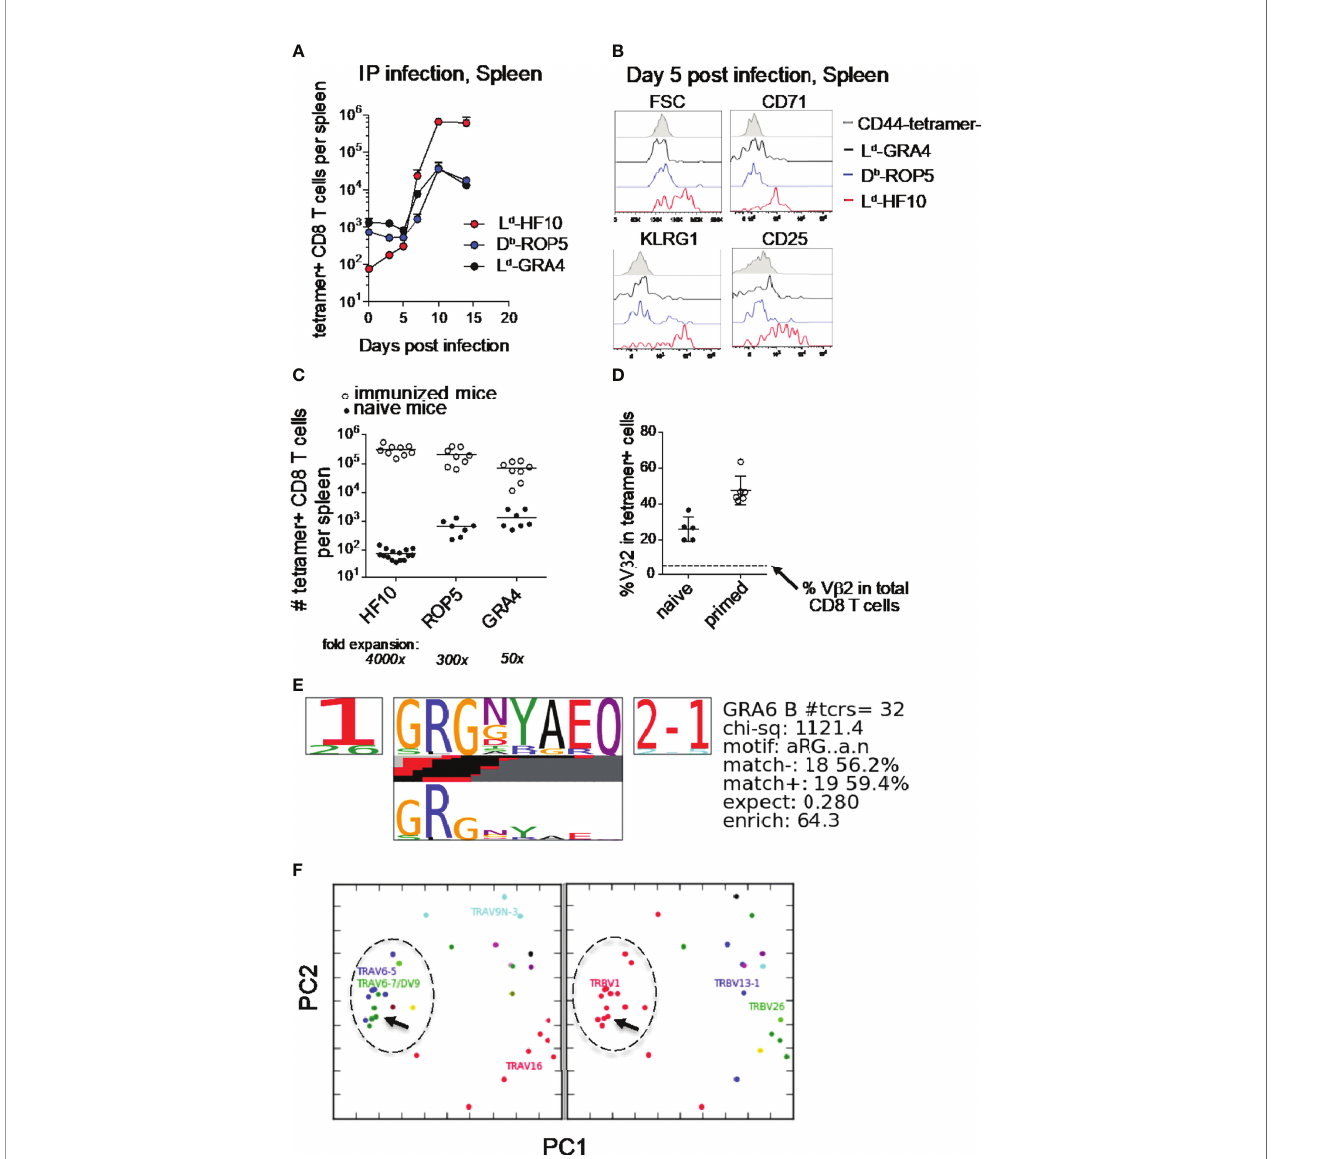
FIGURE 1 | Characteristics of the L d -HF10 speci fi c T cell response. (A) T. gondii -speci fi c CD8 T cells were quanti fi ed by pMHC tetramer staining and fl ow cytometry of splenocytes at different time points after intraperitoneal infection of F1 (B6xB6.C) mice. Fold change between naive and expanded T cells was calculated using the average number of tetramer+ cells in each population in naive mice (GRA6 = 74.4, ROP5: 654.9, GRA4: 1330). (B) Flow cytometric analysis of size (FSC or forward scatter) or expression of activation and effector markers (CD71, KLRG1, and CD25) on gated tetramer + splenic CD8 T cells at day 5 post infection. (C) Mice were immunized with bone marrow-derived dendritic cells loaded with the indicated peptides. Expanded tetramer + CD8 T cells were quanti fi ed by tetramer staining of splenocytes 7 days post immunization (open circles). Numbers of tetramer + CD8 T cells in the spleen were quanti fi ed by tetramer enrichment of naïve mice and were used to calculate the fold expansion of each antigen-speci fi c T cell population (closed circles). Statistical signi fi cance of differences in fold change between the three groups was calculated using Mann- Whitney tests. GRA6 vs. GRA4: p < 0.0001, GRA6 vs. ROP5: p < 0.0001, GRA4 vs. ROP5: p=0.0002. Statistical signi fi cance between tetramer+ T cell populations was calculated by two-way ANOVA. The interaction p-values are as follows: GRA6 vs. GRA4: p < 0.0001, GRA6 vs. ROP5: p < 0.0001, GRA4 vs. ROP5: p=0.99. (D) The frequency of V b 2 usage amongst L d -HF10 speci fi c splenic CD8 T cells tetramer enriched from naïve mice or found in T. gondii -infected mice was determined by fl ow cytometry. Each dot represents an individual mouse and the dashed line indicates the frequency of V b 2 amongst total splenic CD8 T cells (5.40%). (E, F) L d -HF10 tetramer + CD8 T cells were sorted from mice 3 weeks post infection and TCR a and TCR b genes from individual T cells were sequenced as described (39). Clonal diversity in L d -HF10 speci fi c CD8 T cells was analyzed using the TCRdist algorithm (40). (E) Top-scoring CDR3 b motif. Results of a CDR3 motif discovery algorithm are shown using a TCR logo that summarizes V and J usage, CDR3 amino acid enrichment, and inferred rearrangement structures. The bottom panel shows the motif enriched by calculating against a background dataset of non-epitope speci fi c TCR sequences. (F) Principal components analysis (PCA) projection of the TCRdist landscape colored by V a (left panel) and V b (right panel) gene usage. The groups of TCRs that correspond to the top scoring CDR3 b motif are indicated with a dashed circle, and the TG6 TCR is indicated with an